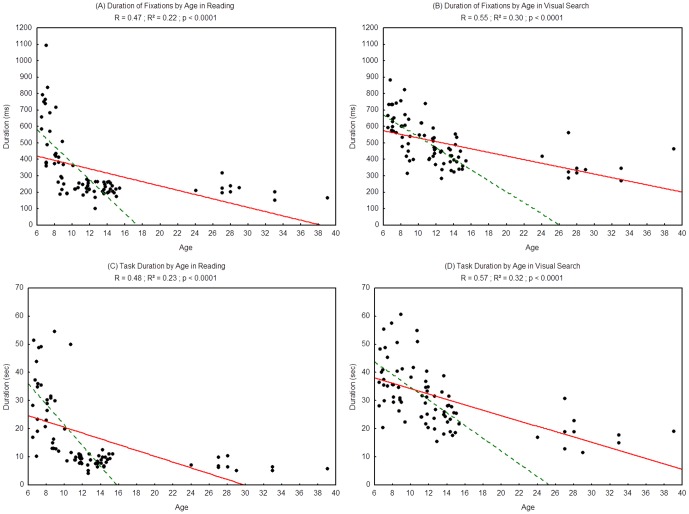
Duration of fixations during reading (A) and during visual search (B) and task duration in reading (C) and visual search (D).Lines represent the corresponding regressions. Dotted lines represent the regressions for children only (from 6 to 15 years old), 2A: R2 = 0.51, p<0.0001; 2B: R2 = 0.48, p<0.0001; 2C: R2 = 0.45, p<0.0001; 2D: R2 = 0.45; p<0.001.